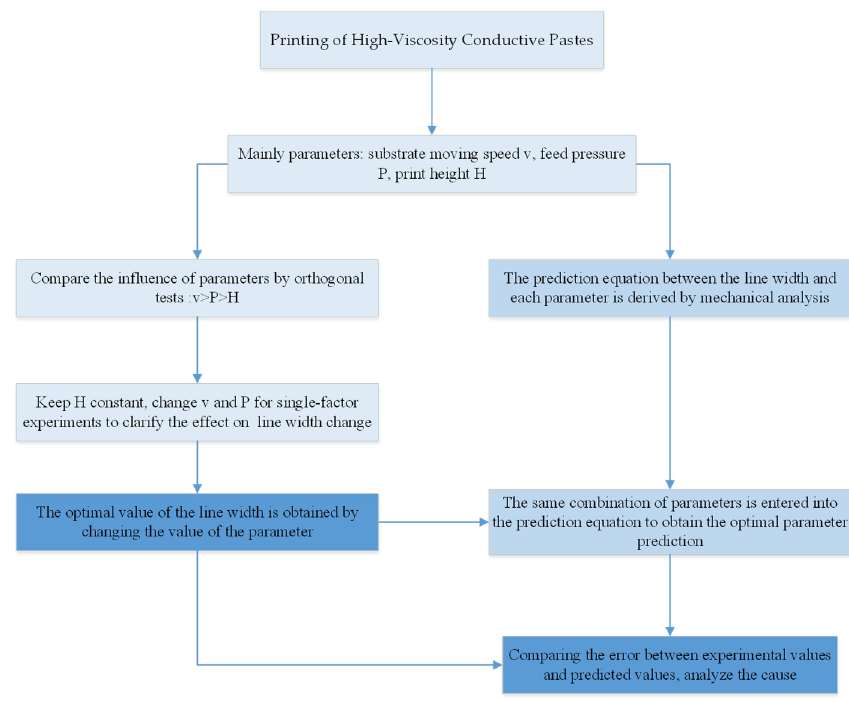
Figure 3. Flow chart of research steps.